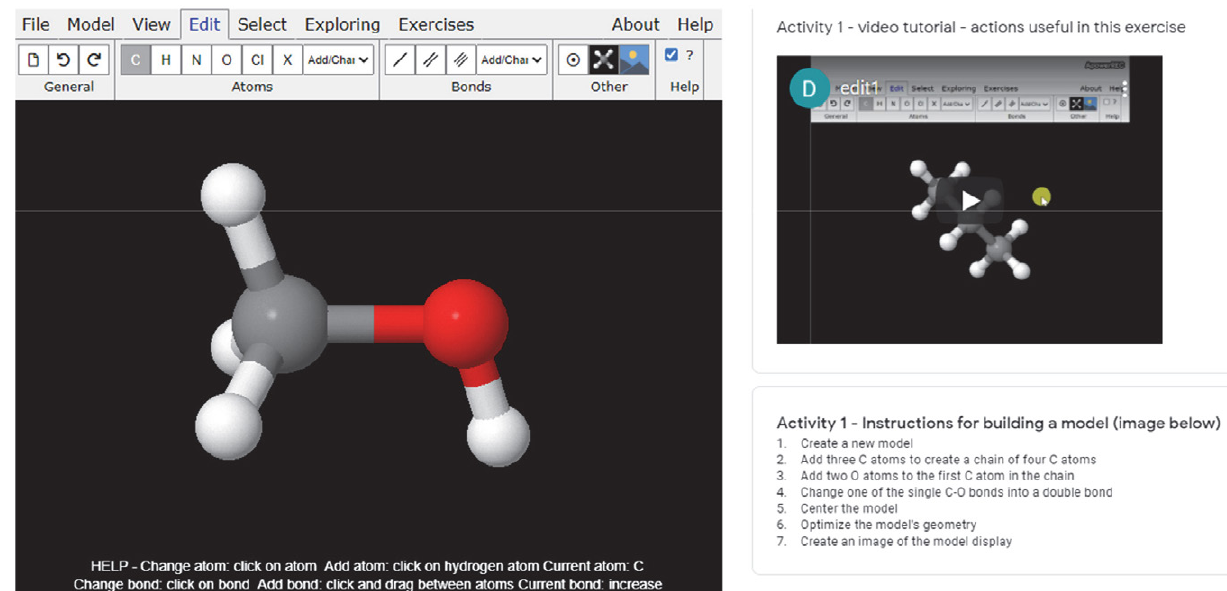
Figure 2: Activity display for the first activity (left: interface for model building, right: activity